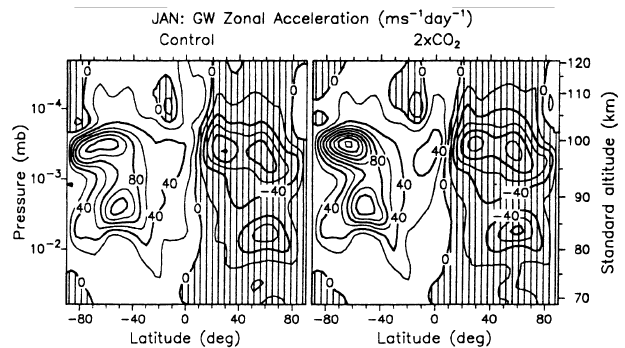
Fig. 11. Global mean temperature as a function of pressure ( left panel ): control experiments ( dashed ), 2 (cid:2) CO 2 experiments ( solid ); January ( left curves ), April ( right curves ) shifted by 200 K). Global mean temperature di(cid:128)erence (cid:133) 2 (cid:2) CO 2 (cid:255) Control), as a function of pressure ( right panel ): January ( solid ), April ( dashed , shifted by 10 K)